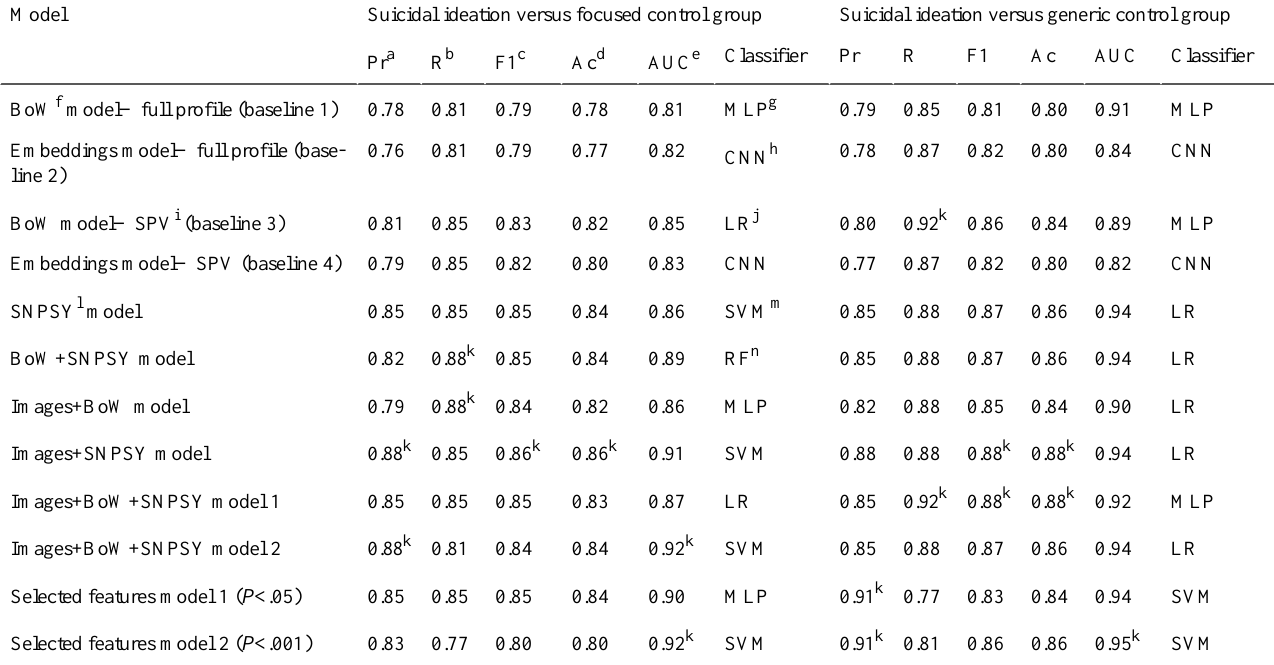
Table 9. Predictive task